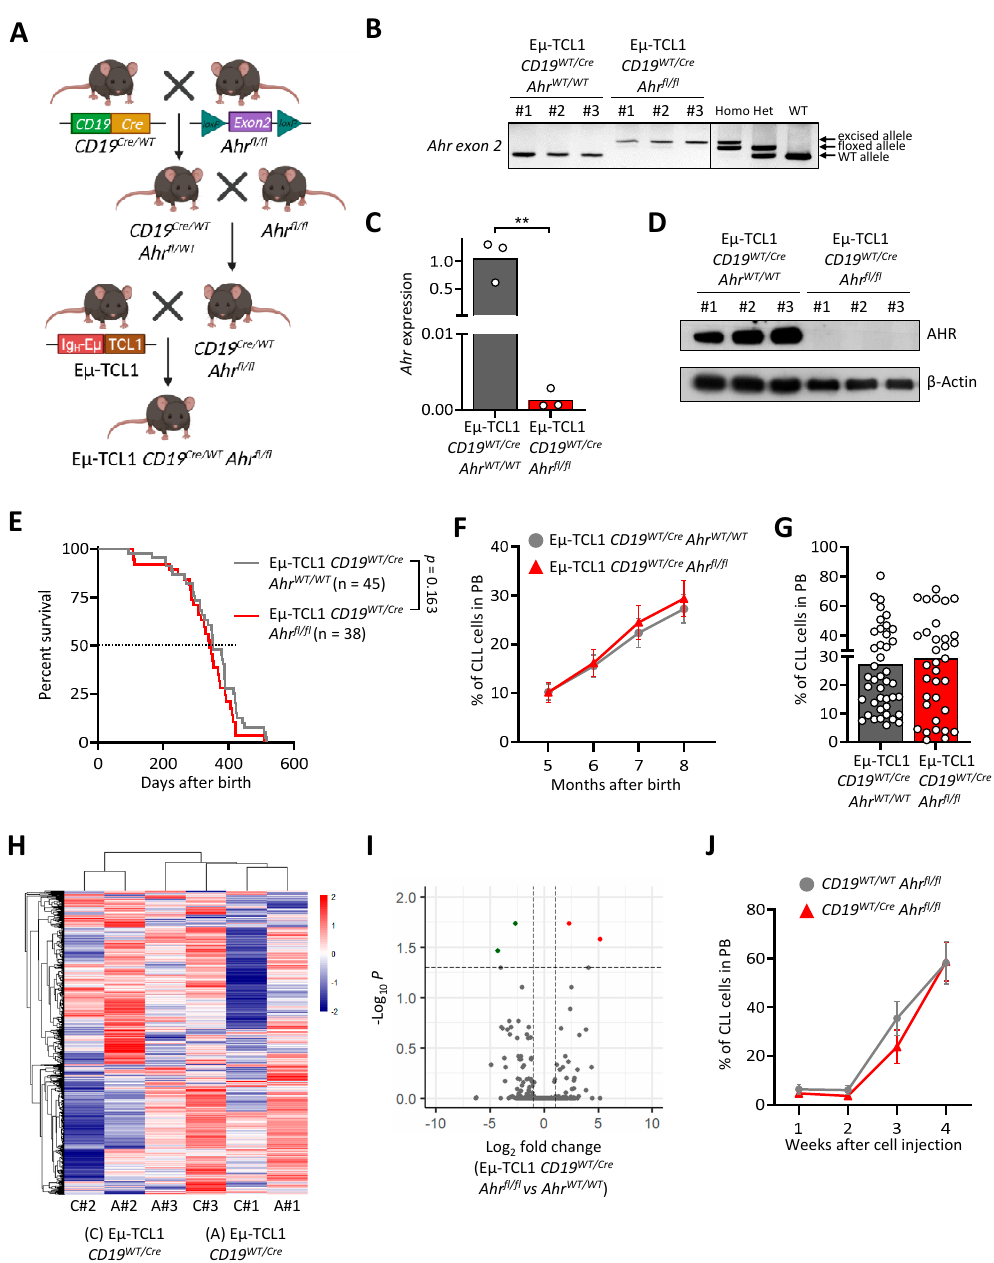
Figure 3. AHR knock-out does not influence CLL development in the murine E µ -TCL1 model. ( A ) Scheme of the breeding strategy to generate E µ -TCL1 CD19 Cre/WT Ahr fl/fl (cKO) mice. ( B – D ) Validation of the knock-out of exon 2 of Ahr in isolated B cells from cKO mice incubated with FICZ at the DNA ( B ), RNA ( C ), and protein ( D ) levels compared to control mice (n = 3). ** p < 0.01. ( E ) Survival curve of cKO compared to control mice shows no significant difference. (Ctrl: n = 45, cKO: n = 38). ( F , G ) Flow cytometry analysis of CLL cells (CD19+ CD5+) in the peripheral blood (PB) of cKO and control mice over time (Ctrl: n = 45, cKO: n = 38) ( F ) and at month 8 (Ctrl: n = 42, cKO: n = 34) ( G ). ( H , I ) CLL cells from cKO and control mice (n = 3) were subjected to RNA sequencing. ( H ) Unsupervised hierarchical clustering showing the top 10,000 most expressed genes. ( I ) Volcano plot showing DEG between cKO and control mice. ( J ) CLL development of the adoptive transfer of Eµ-TCL1 CLL cells in CD19 Cre/WT Ahr fl/fl mice (Ctrl: n = 5, cKO: n = 5).